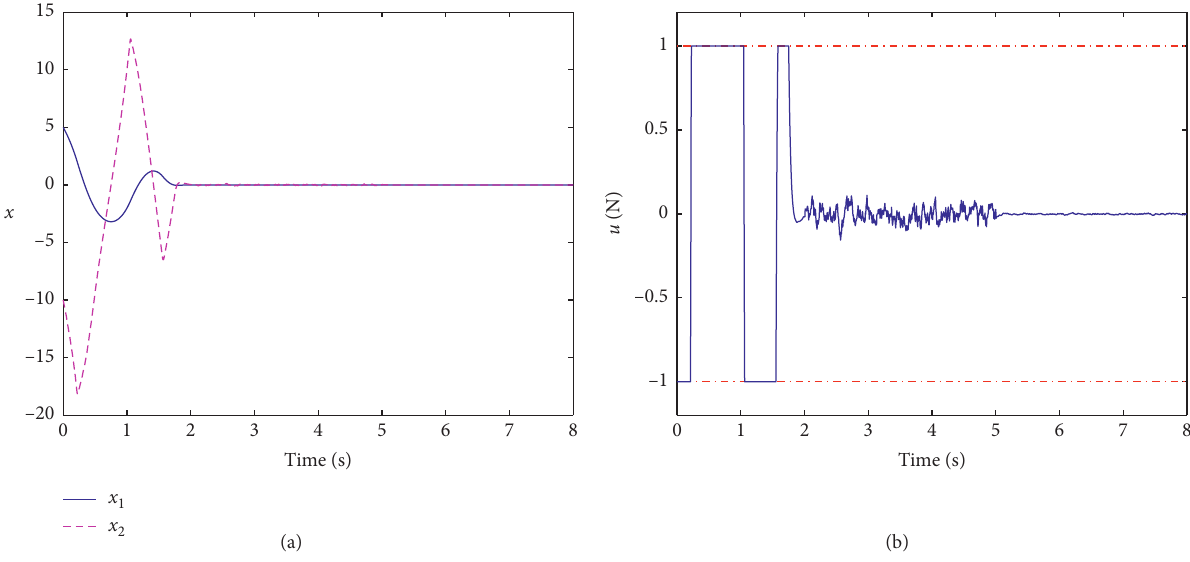
Figure 8: Temporal evolution of the two states x feedback control law u for the saturation level u ( P , c ) in Figure ellipsoid ε ⋆ ⋆ ⋆